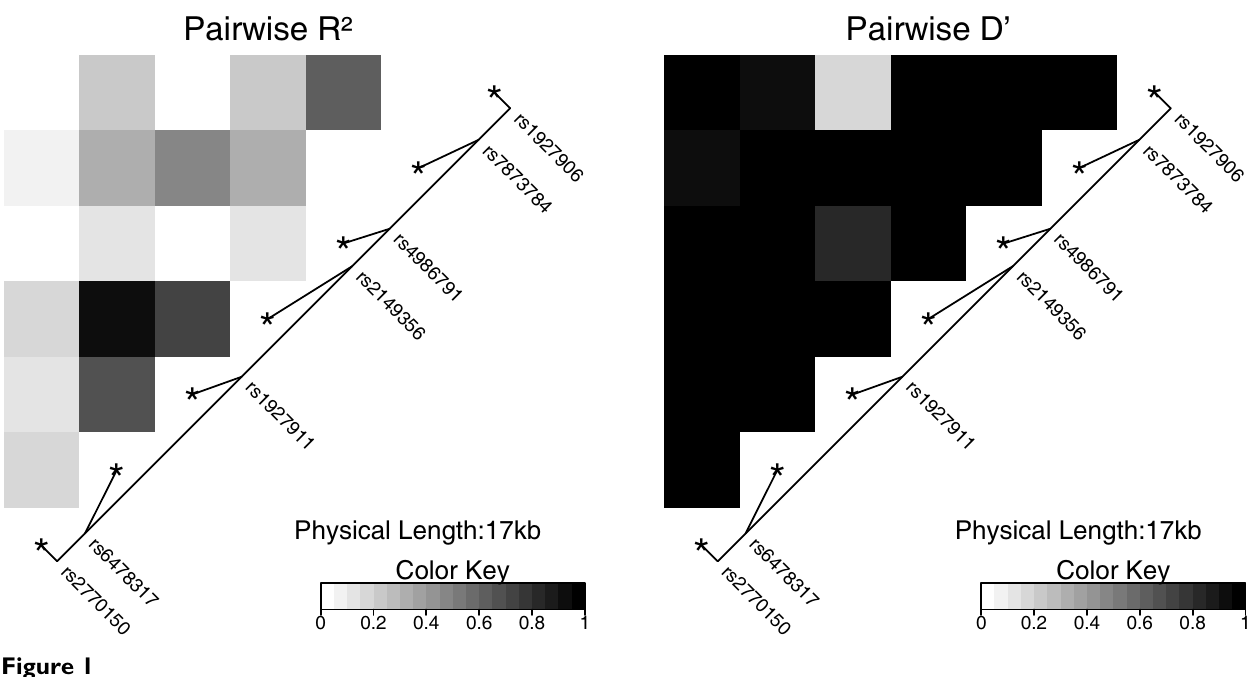
Structure of the TLR4 gene and pairwise LD D' und r 2 plots